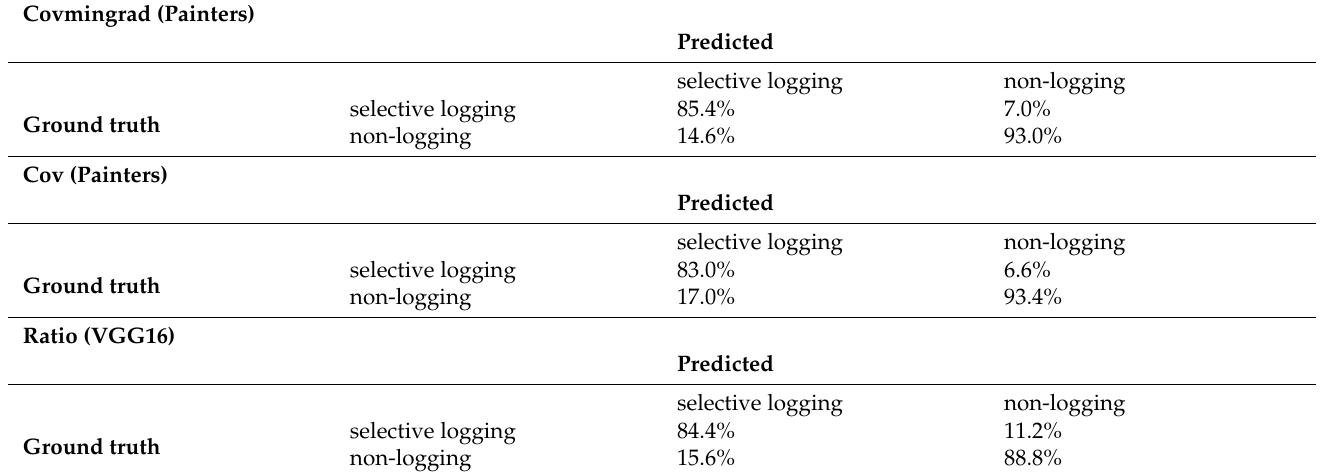
Table 3. Confusion matrix containing the results (percentage in relation to the prediction) of the generalization test. Covmingrad (Painters)—Generalization Test